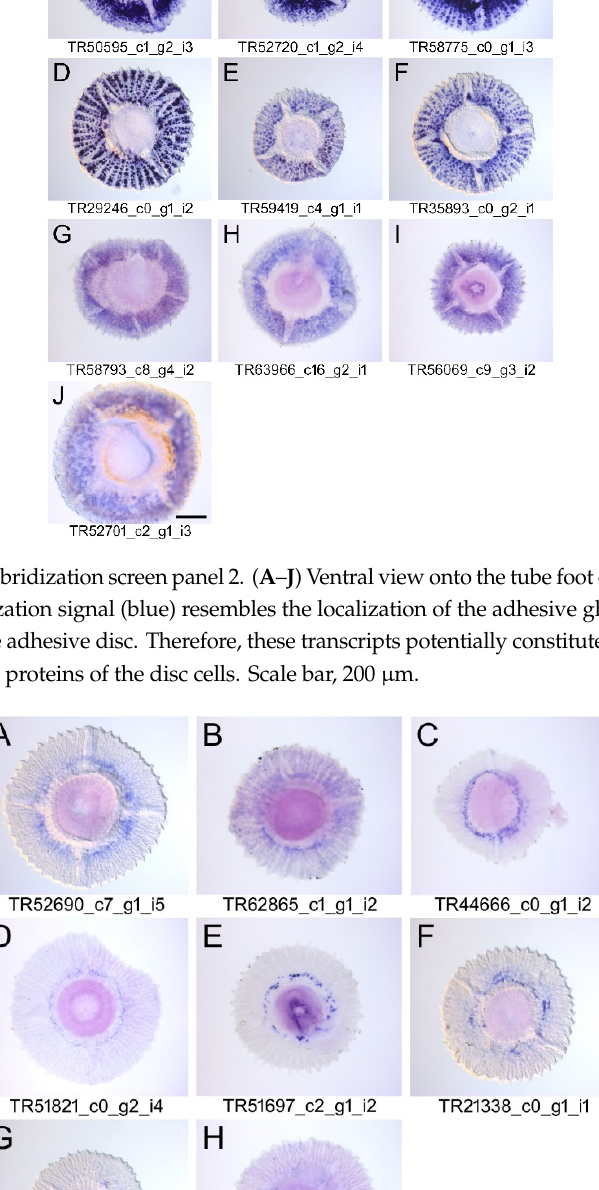
Figure A1. In situ hybridization screen panel 1. ( A – J ) Ventral view onto the tube foot disc. The distribution of the in situ hybridization signal (blue) resembles the localization of the adhesive gland cells bodies. Therefore, these transcripts potentially constitute proteins involved in bioadhesion. Scale bar, 200 µm.